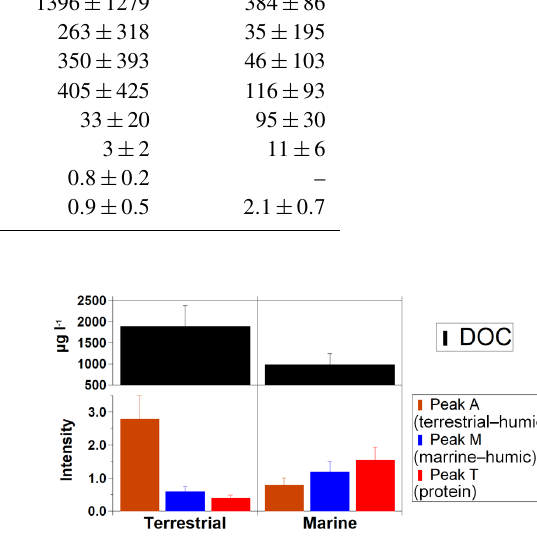
Figure 9. Average DOC concentrations for surface seawater sam- ples collected during this cruise, simultaneous with the atmo- spheric measurements reported herein. Peak A, M and T represent terrestrial–humic substances, marine–fulvic substances and protein,